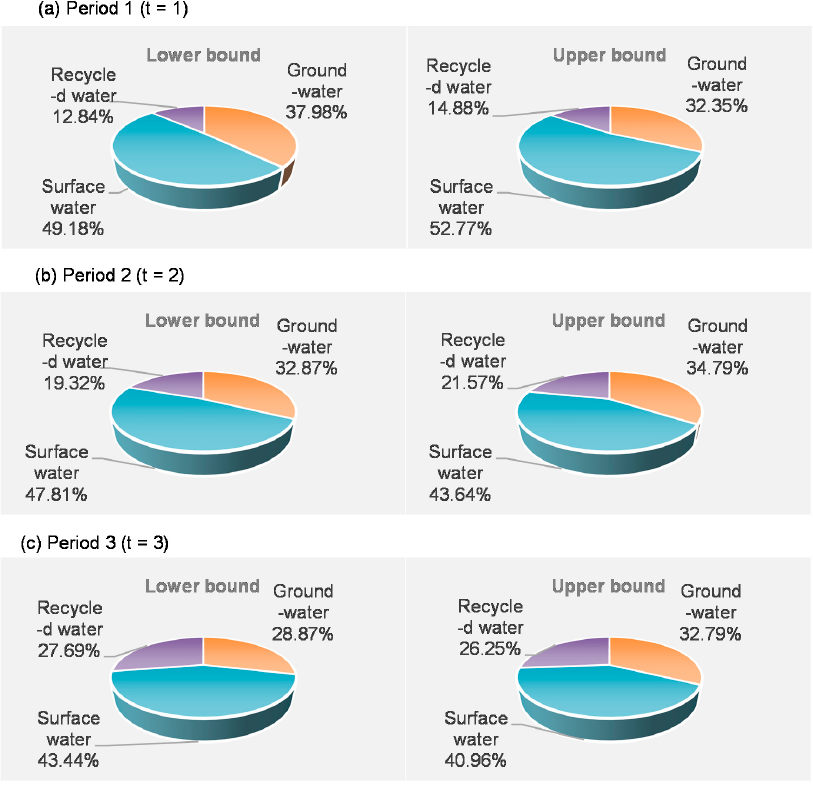
Figure 6. Distribution of water allocation in each period: ( a ) period 1 ( t = 1); ( b ) period 2 ( t = 2); ( c ) period 3 ( t = 3).